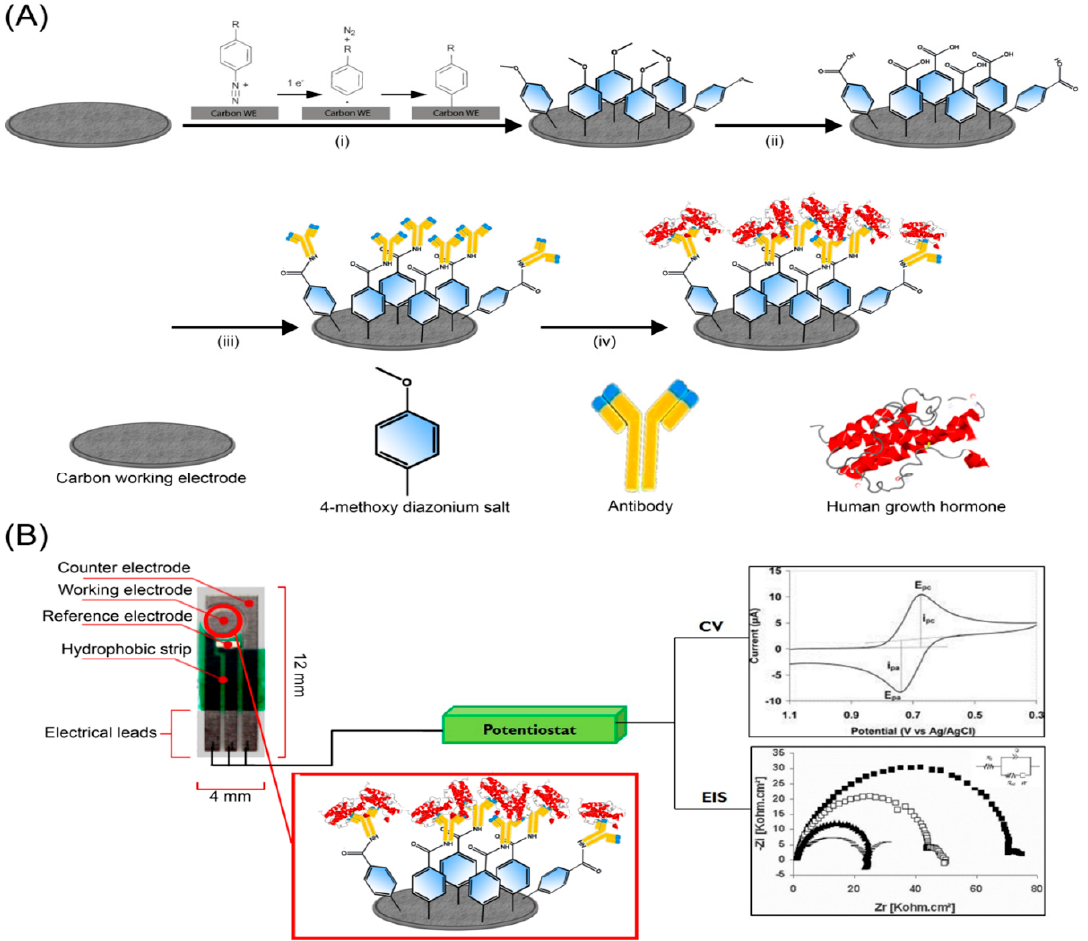
Figure 1. Conceptual illustration of the impedimetric detection of rat growth hormone (GH). ( A ) A film of 4-methoxybenzenediazonium tetrafluroborate (4-MBD) was immobilized on an electrode surface by electrodeposition (i); surface-confined 4-MBD molecules were electrochemically oxidized to carboxylic acid groups (ii) that were activated with 1-ethyl-3-(3-dimethyl-aminopropyl) carbodiimide (EDC) and N-hydroxysuccinimide (NHS) to allow subsequent covalent immobilization of antibodies via lysine residues (iii); GH is captured with antibodies on the surface (iv). ( B ) screen-printed carbon electrodes (SPCE) of dimension 4 × 12 mm in length with carbon ink-based working and counter electrodes in connection with a silver ink-based reference electrode. Electrochemical impedance spectroscopy (EIS) and cyclic voltammetry (CV) were employed to characterize SPCE and glassy carbon electrode (GCE) surfaces.